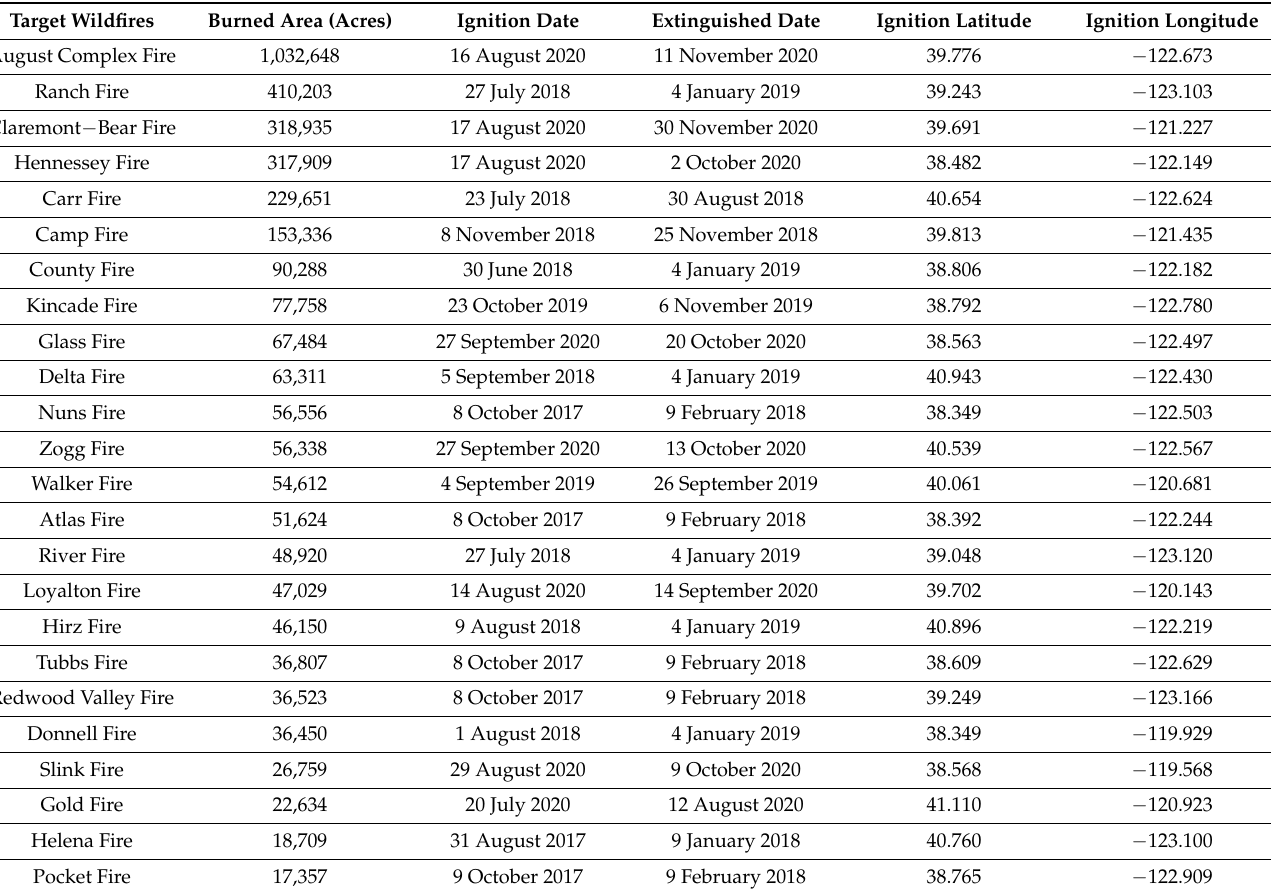
Table 1. Target wildfire